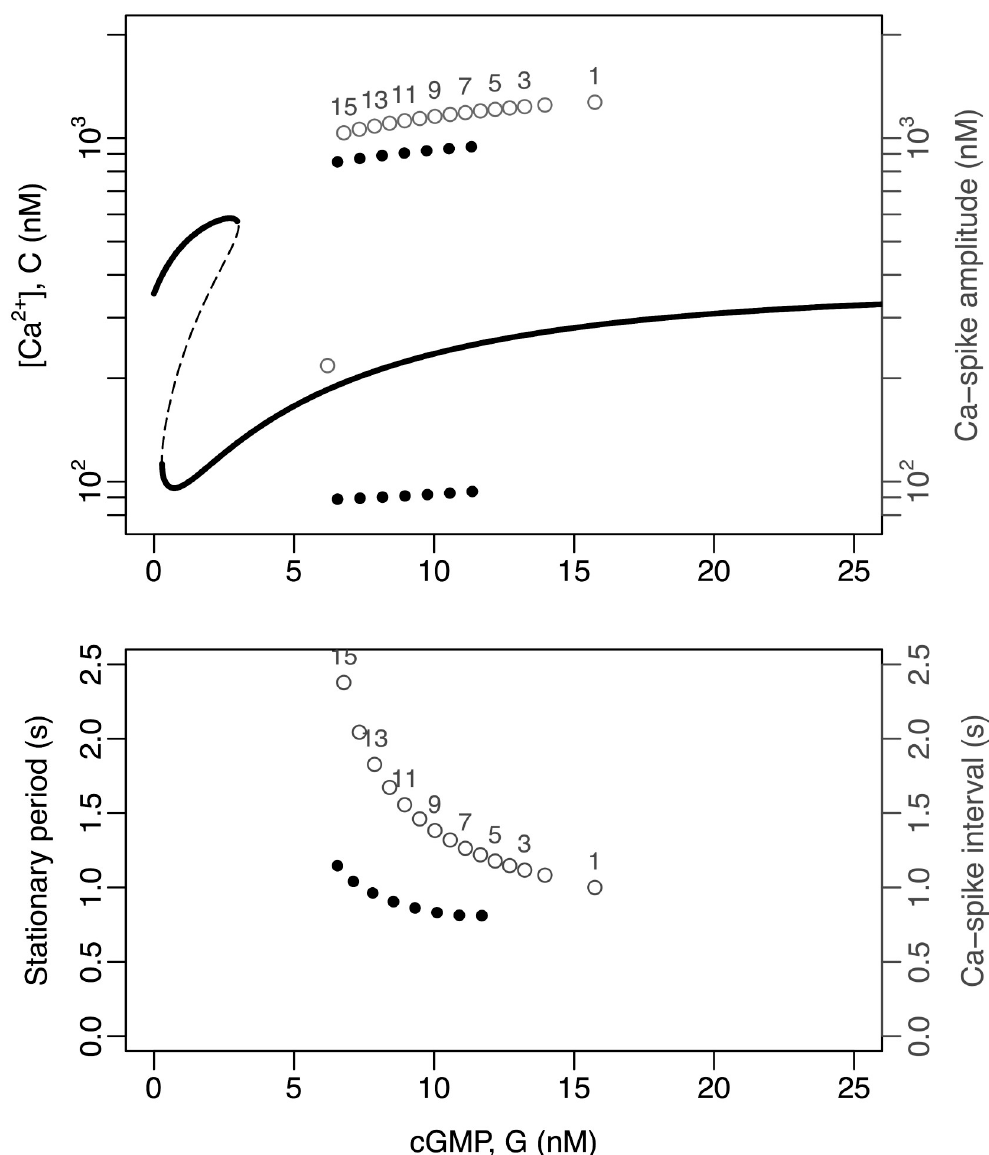
Fig 7. Bifurcation analysis of the model featuring the CatSper+NHE module. The analysis was done under conditions wherein cGMP is defined as a constant input ( G = constant) and upstream variables ignored reducing the state space to f f o , f o , V , f a , m cs , h cs , C , H }. Top: The graphs depict the variable C ([Ca 2+ ] i ) as a function of the input parameter G (cGMP kn hc nh concentration). The thick continuous lines are the stable equilibria and the dashed lines indicate unstable equilibria, as obtained by XPPAUT [24]. The thick dotted lines are the maxima and minima of the stable limit cycle obtained by numerical solutions of the system under random initial conditions. The numbered gray dots indicate the maxima and minima of the consecutive spikes obtained by solving numerically the full model, corresponding to those depicted in Fig 4. Bottom: The dotted lines represent the period of the stable limit cycles as a function of the constant input G obtained by numerical solutions. The numbered grey dots correspond to the interspike interval in the numerical solutions, as in the top graph.